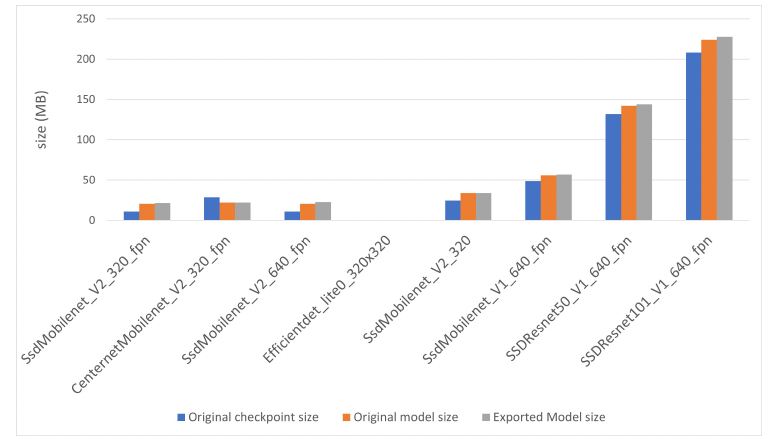
Figure 7. TensorFlow file sizes for object detection models.